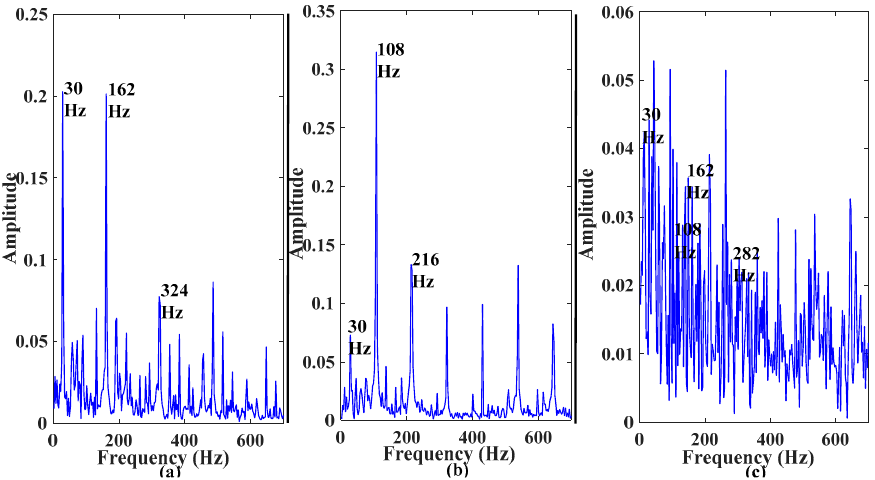
Figure 2. Envelope power spectrum: ( a ) inner raceway fault; ( b ) outer raceway fault, and ( c ) roller element fault. Table 2. Statistical features extracted from the envelope power spectrum.